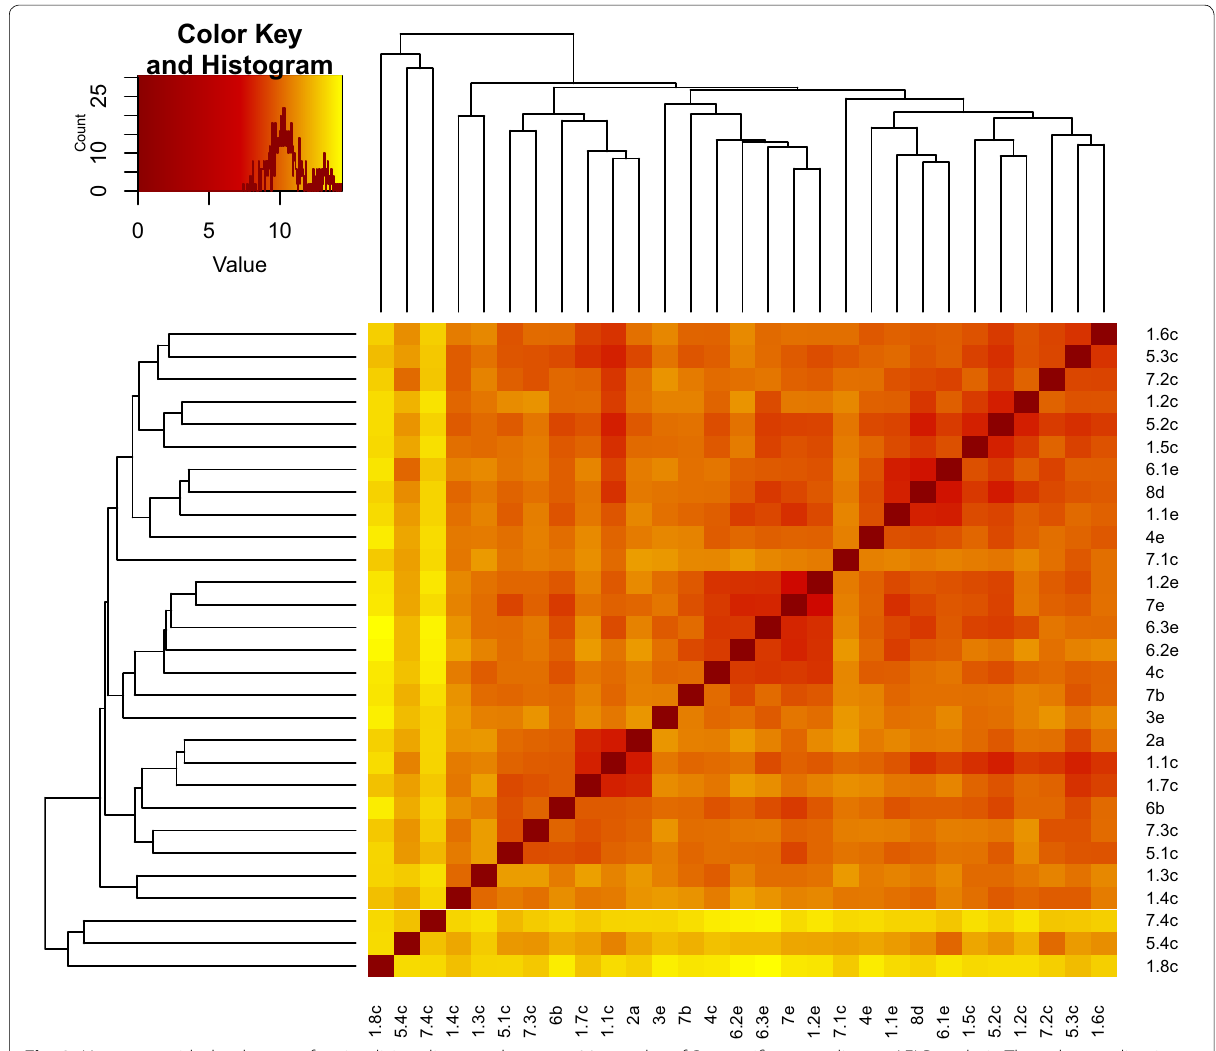
Fig. 3 Heat map with dendrogram for visualizing distances between 29 samples of P. magnifica according to AFLP analysis. The colour coding is proportional to the value of the dissimilarity between observations: dark red if dist(xi,xj) in the Czech Republic: Veselí I (1), Vlkov (2), Podřezaný (3), Cep I (4), Nový Kanclíř (5), Hejtman (6), Staňkovský (7), and USA (8); within years 2009 (a), 2011 (b), 2012 (c), 2013 (d) and 2014